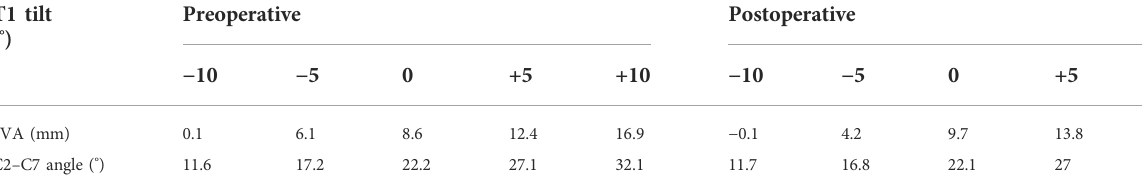
TABLE 1 Cervical SVAs and C2 – C7 angles measured in the pre- and post-operative C2 – T1 FE models of different T1 tilts.